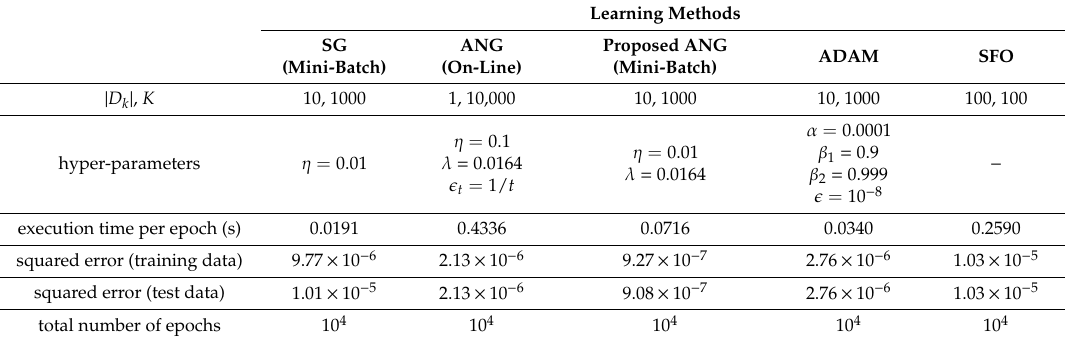
Table 1. Hyper parameters and training performances on Mackey-Glass time series data.